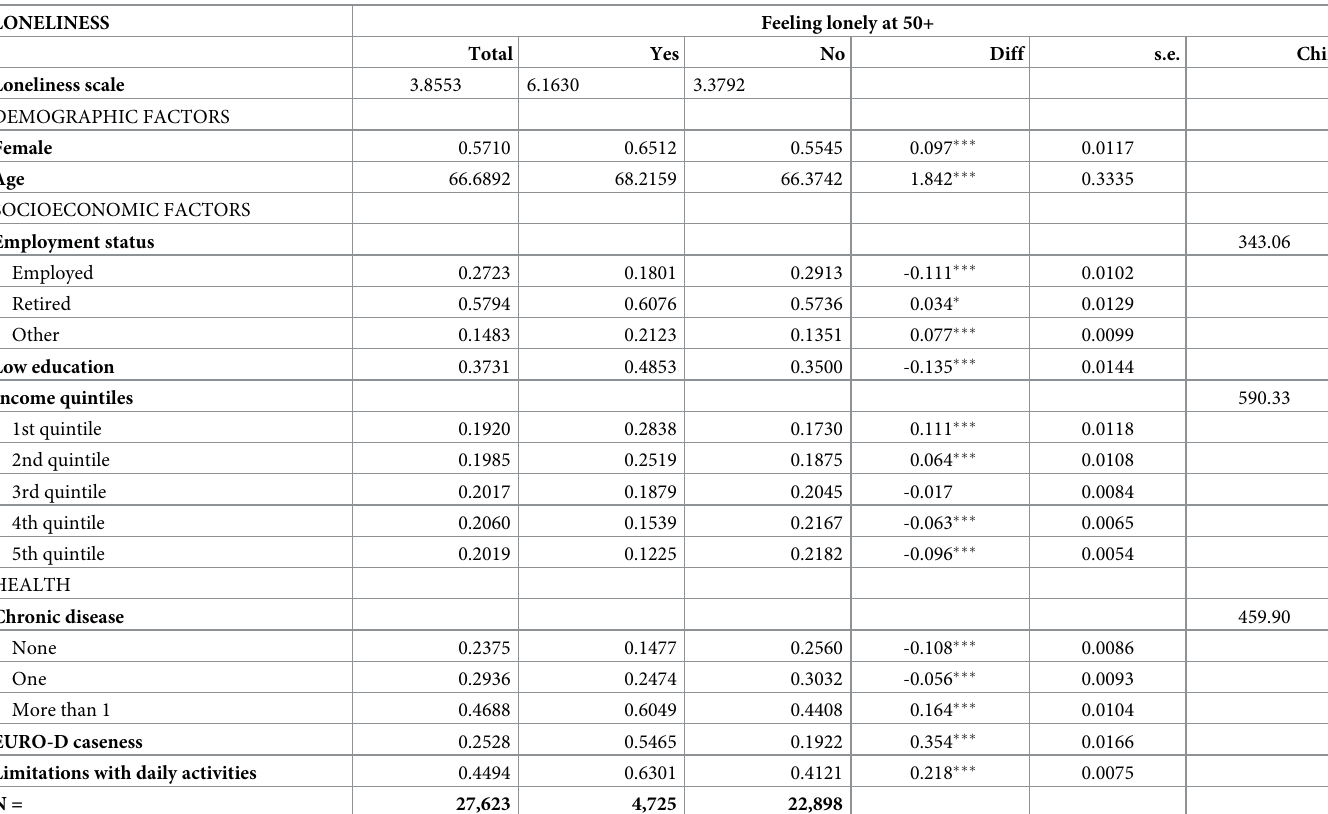
Table 2. Loneliness at age 50+ by demographic, socioeconomic, and health